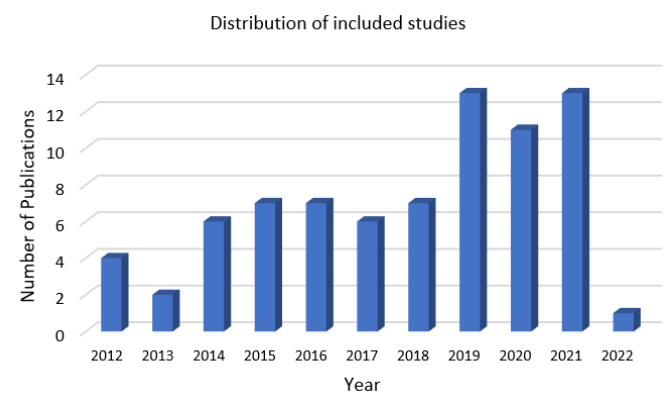
Figure 2. Distribution of all included papers in the studies.